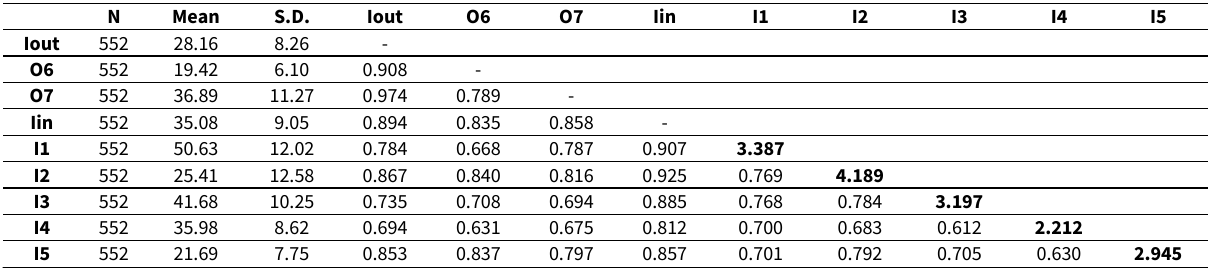
Table 6. Descriptive statistics, correlation matrix and variance inflation factors (VIF)